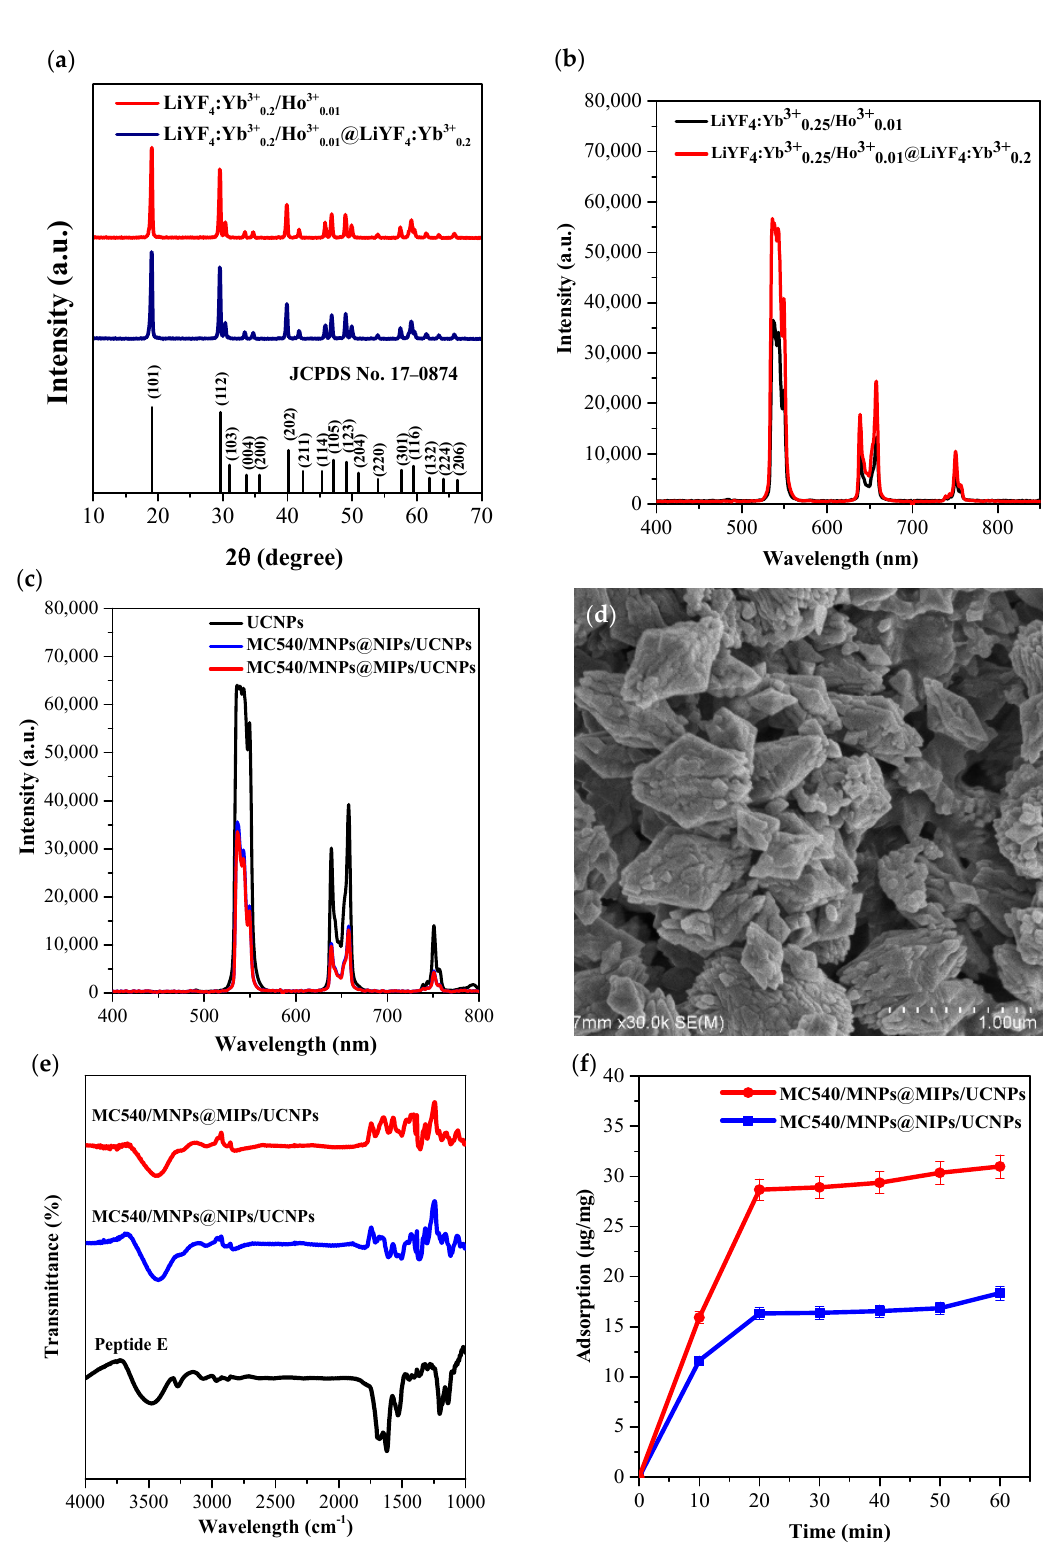
Figure 2. ( a ) X-ray diffraction and ( b ) photoluminescence of LiYF 4 :Yb 3+0.25 /Ho 3+0.01 and LiYF 4 :Yb 3+0.25 /Ho 3+0.01 @ LiYF 4 :Yb 3+0.2 UCNPs. ( c ) Photoluminescence of MC540-grafted MNPs at UCNPs-embedded peptide-imprinted polymer. ( d ) SEM image of the UCNP-embedded peptide-imprinted polymers. ( e ) FTIR and ( f ) binding kinetics of MC540-grafted MNPs in UCNP-embedded non- and peptide-imprinted polymers.